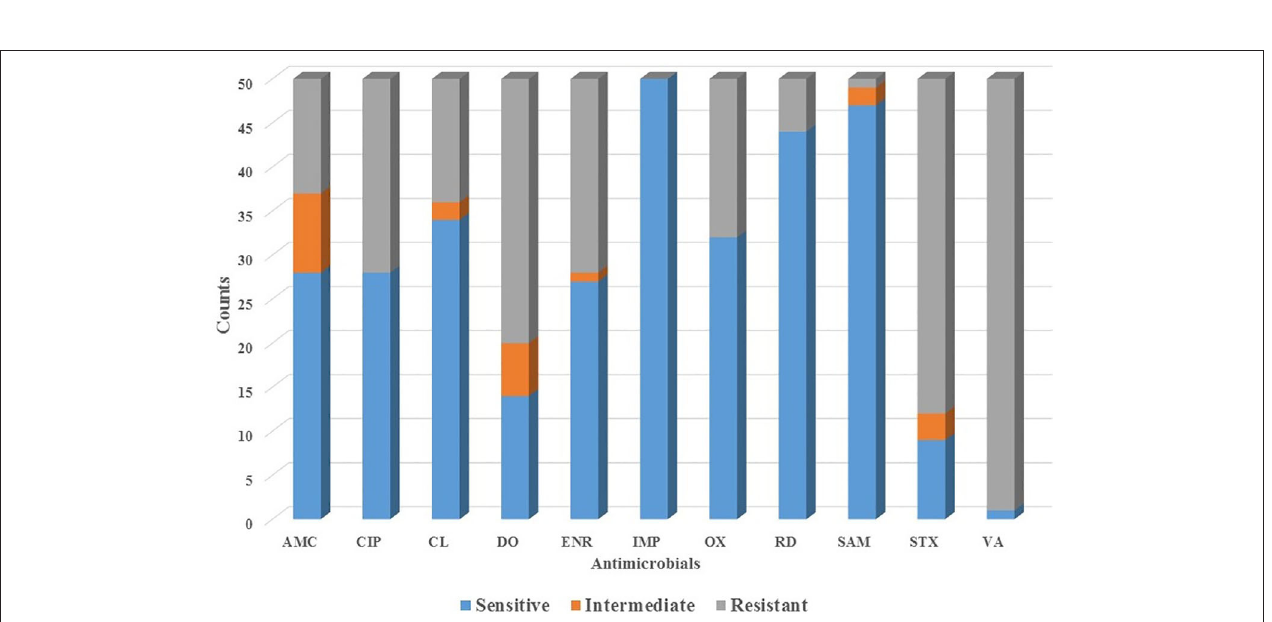
FIGURE 3 | The results of the real-time PCR assay. Detection of the nuc gene of S. schleiferi by electrophoresis. Line A: Marker. Lines B to K: Isolates. NC, Negative control; PC, Positive control. Electrophoresis was run as indicated in Materials and Methods.